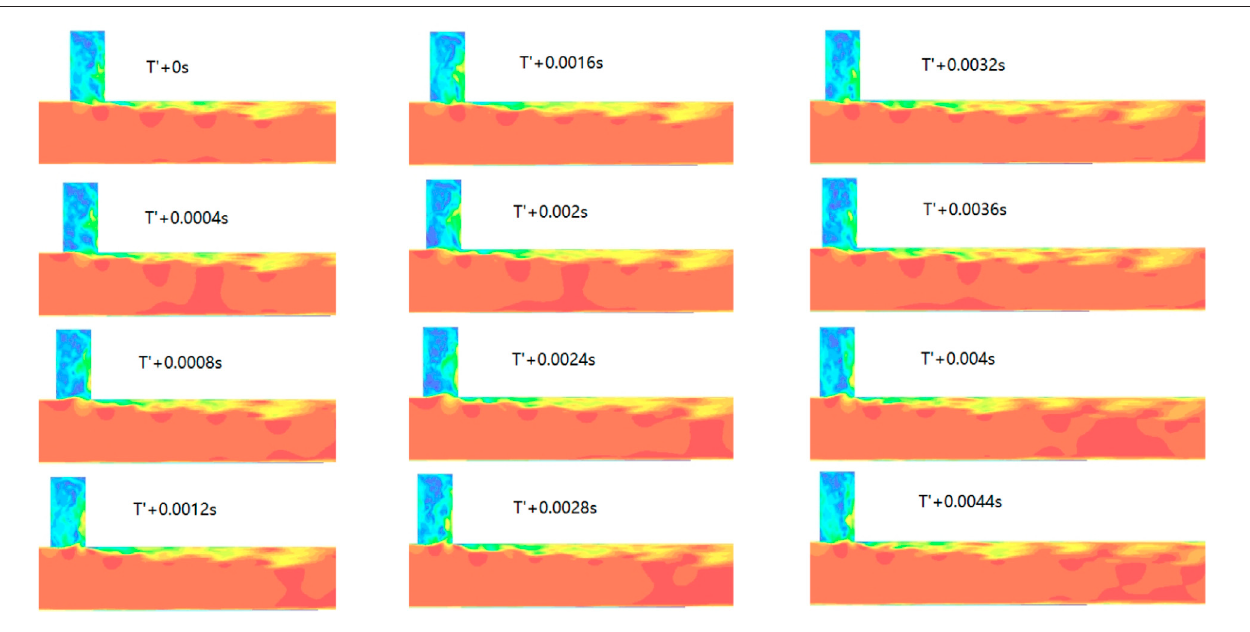
FIGURE 2 | The contour of the periodic variation in the fl ow velocity over time